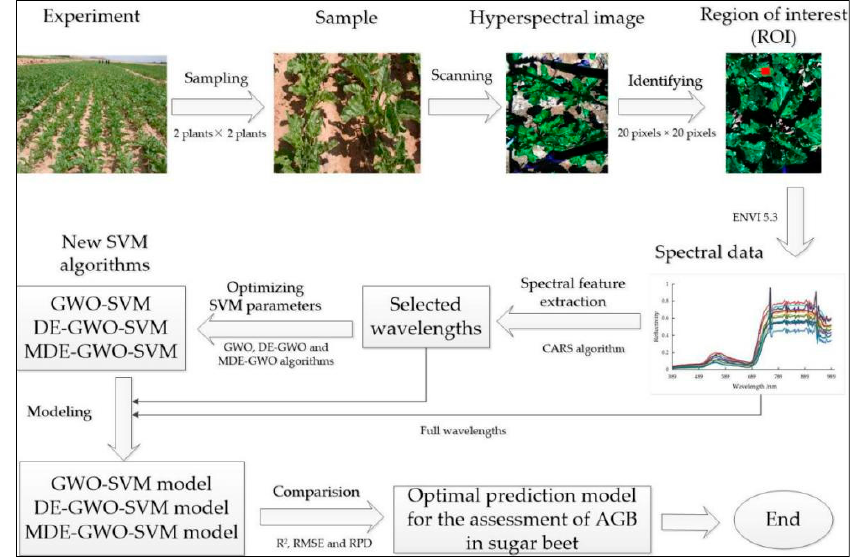
Figure 4. Main steps of above-ground biomass (AGB) prediction of sugar beet using hyperspectral imaging data.